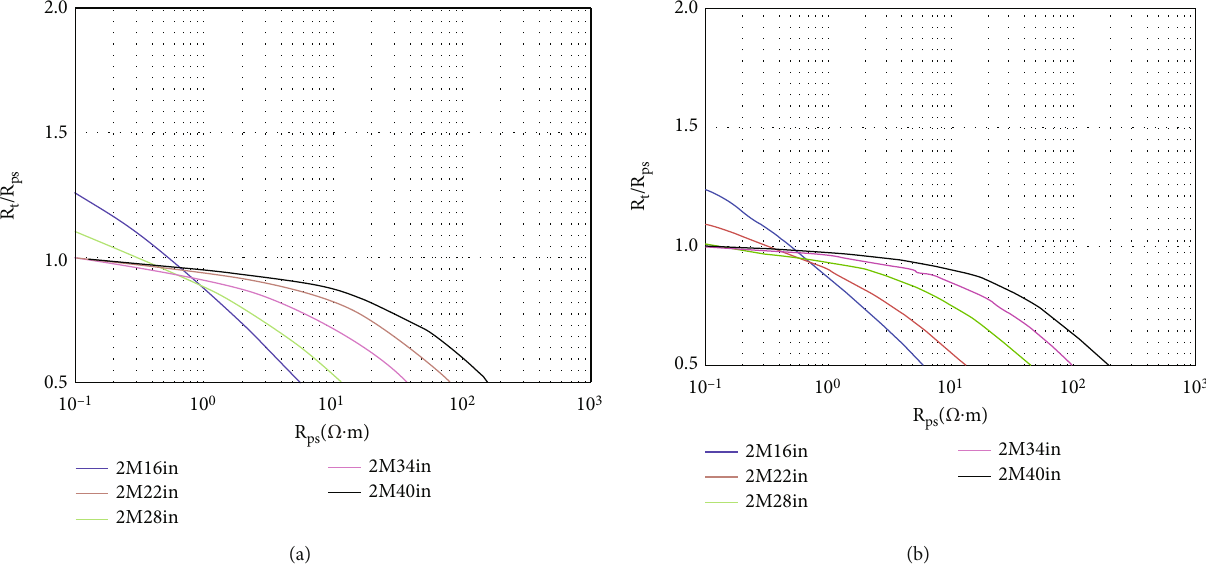
Figure 3: (a) Charts of ARC675 (2 MHz, dh = 14in , Rm = 0 : 02 Ω · m ) in the references. (b) Charts of ARC675 (2 MHz, dh = 14 in , Rm = 0 : 02 Ω · m ) in this